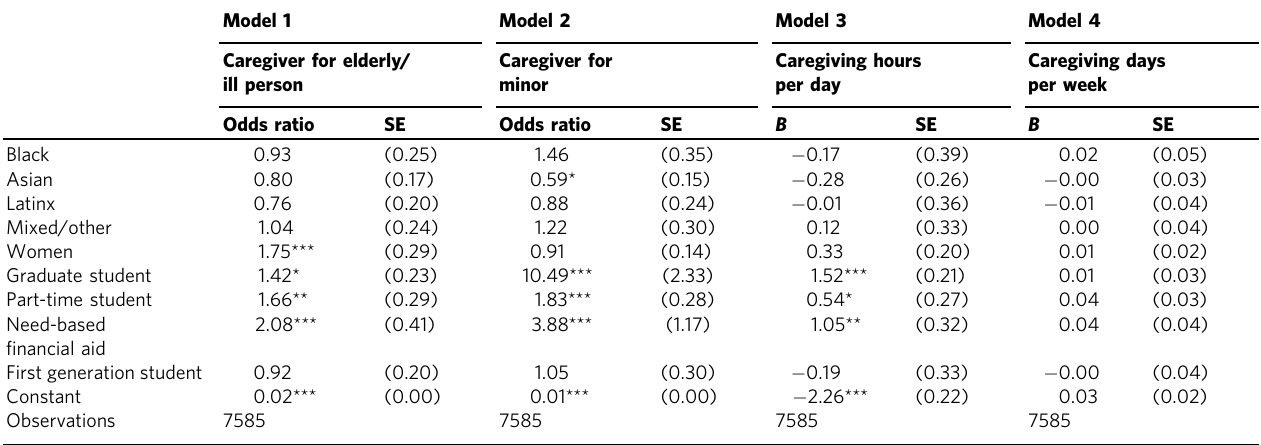
Table 3 Demographic characteristics predicting the likelihood of caregiving and intensity of